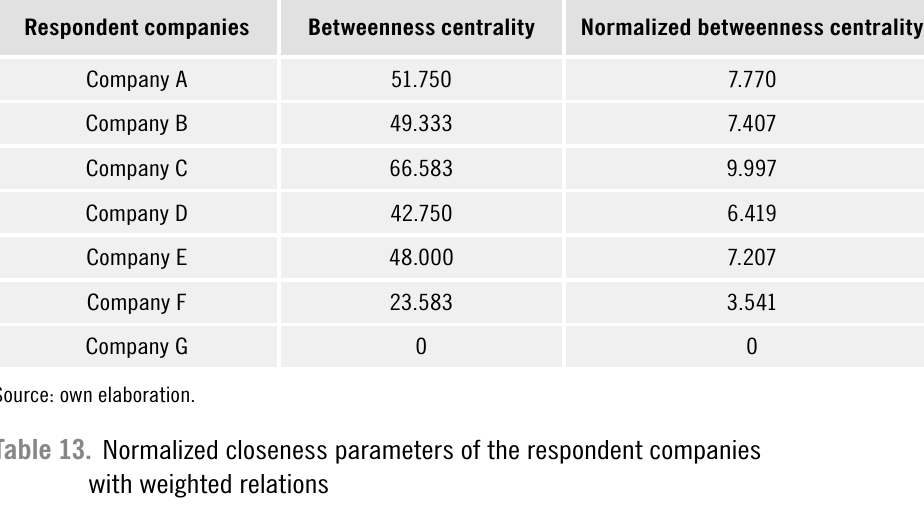
Table 12. Betweenness centrality parameters of the respondent companies with weighted relations